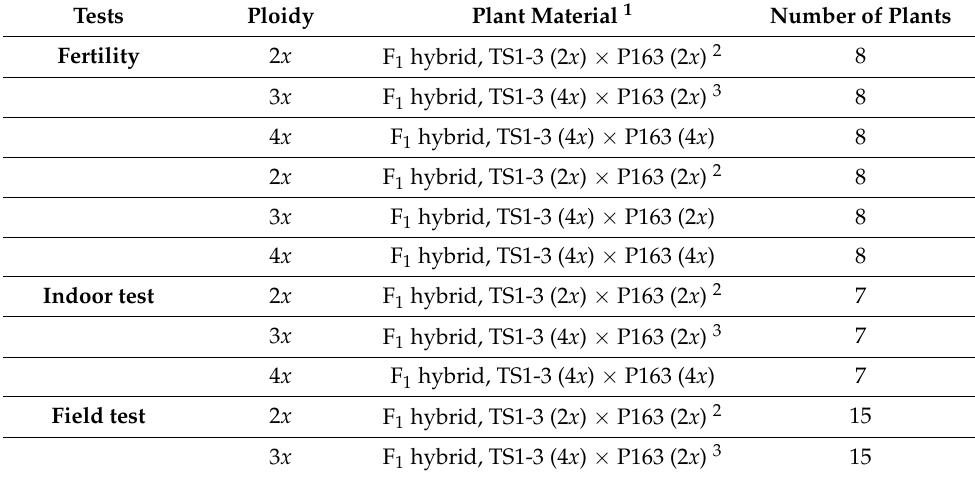
Table 1. Plant material and crossing combinations used in